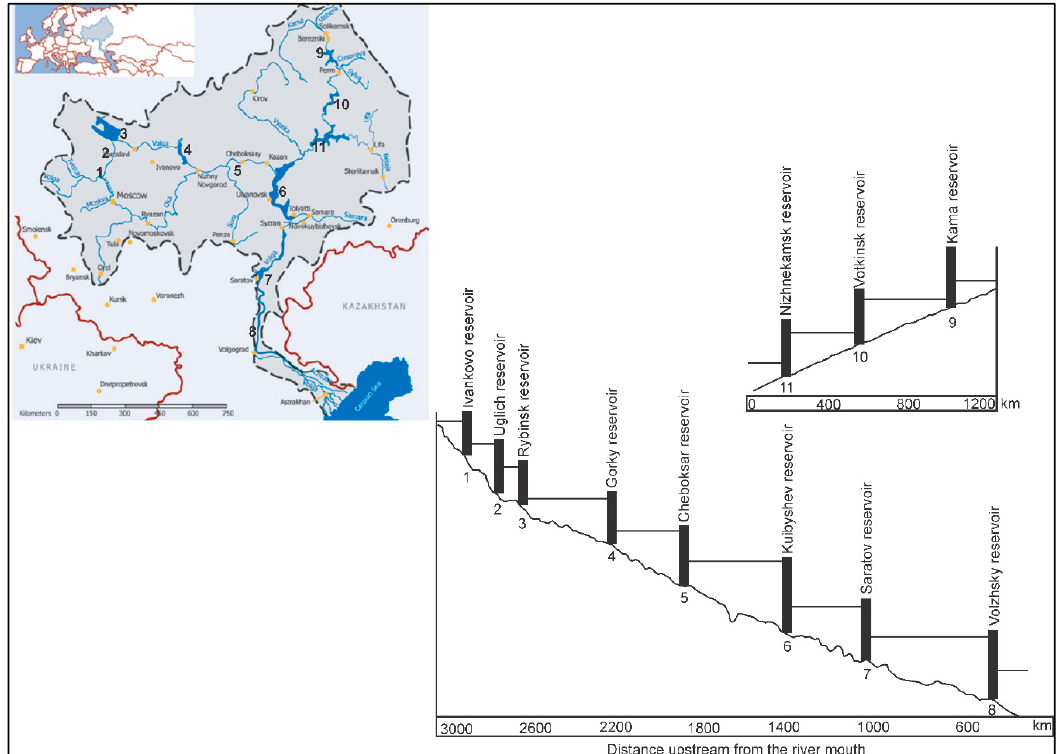
Figure 1. Detail of the reservoirs of the Volga-Kama cascade.